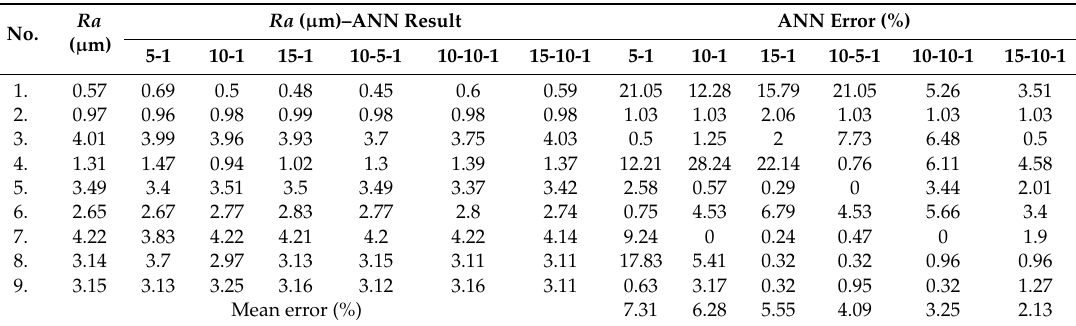
Table 13. Simulation results with calculated error.